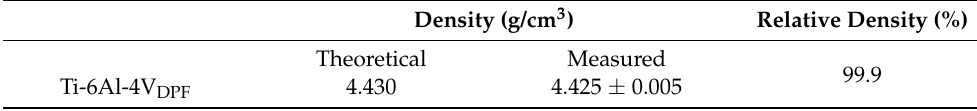
Table 2. Average density of the femoral stem produces via NNS DPF process.